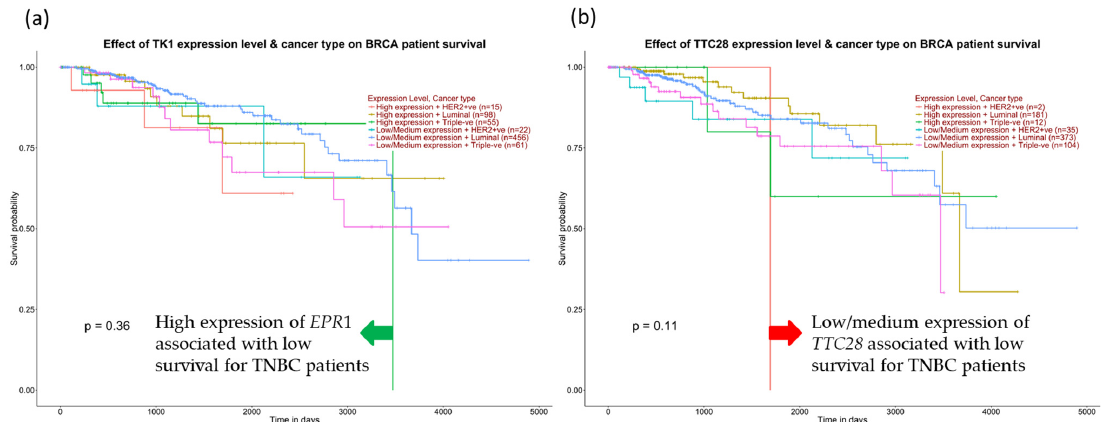
Figure 14. Expression of positive and negative correlation for BIRC5 and TNBC patients’ survival. ( a ) High expression of EPR1 from positively correlated genes decreases TNBC patients’ survival. ( b ) Low expression of TTC28 from the inversely correlated genes drops TNBC survival, accessed from the UALCAN database (Ualcan.path.uab.edu/analysis) on 3 July 2022. We examined the expression of BIRC5 in various cancers. Except for prostate adeno- carcinoma, sarcoma, cutaneous melanoma, thyroid carcinoma, and thymoma, BIRC5 was significantly elevated ( p < 0.05) in all nineteen cancers based on the pan-cancer analysis results (Table 2). Table 2. The expression pattern of BIRC5 in various cancers. The threshold for statistical significance was p < 0.05.